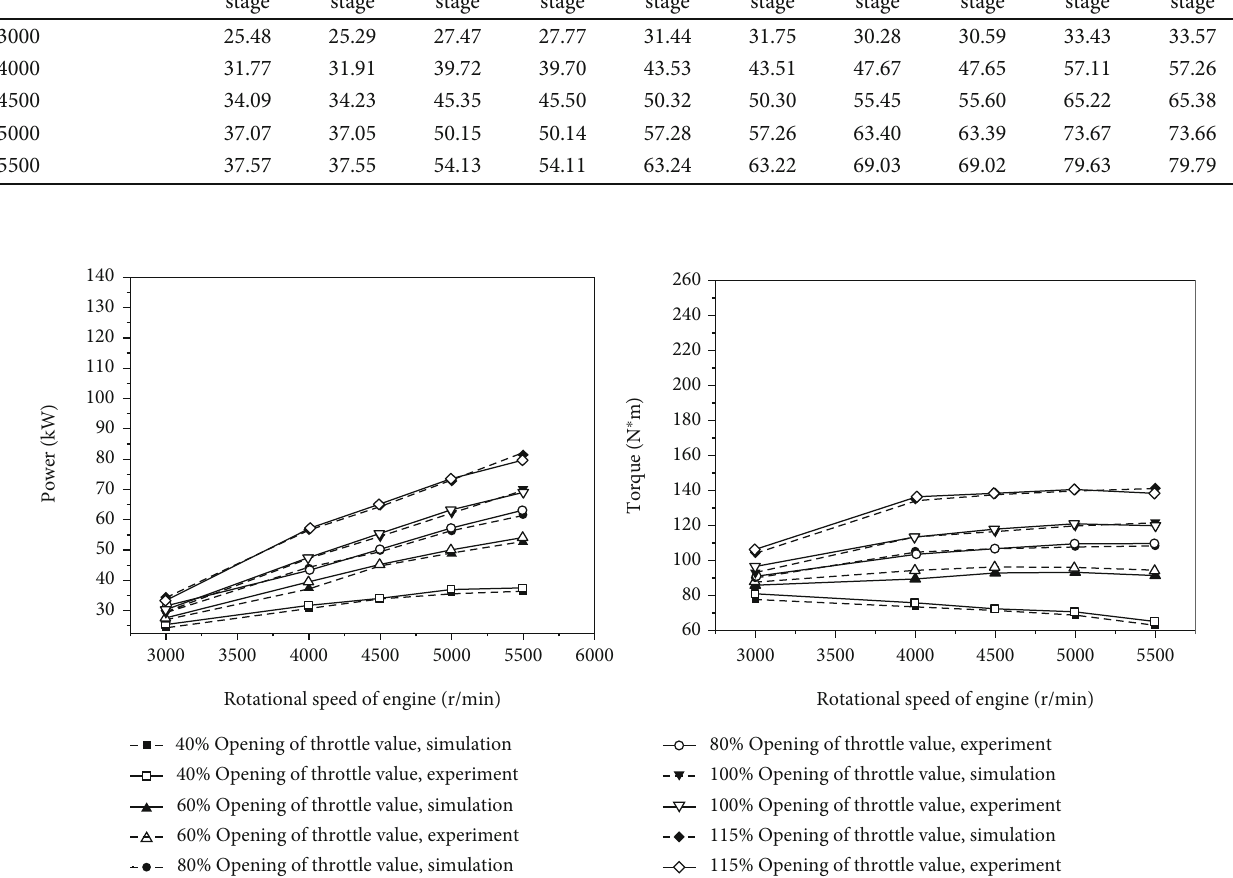
Figure 4: Comparison of the simulated and experimental data of power and